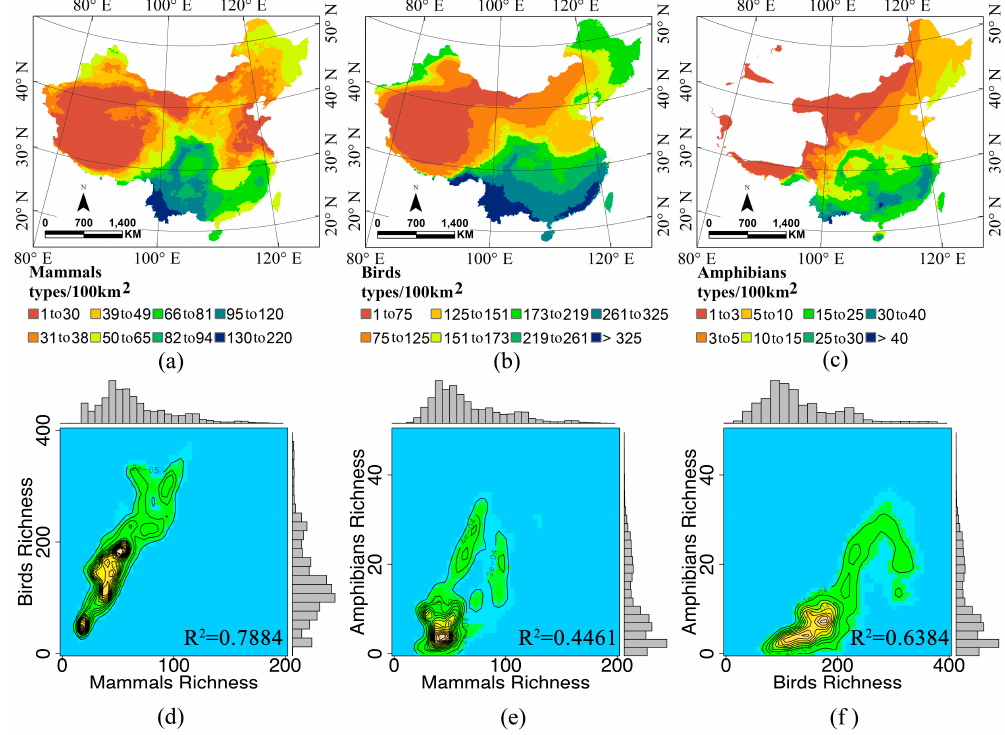
Figure 1. Geographical distribution of species richness based on field surveys (number of species/100 km 2 ) of ( a ) Mammals; ( b ) Birds; and ( c ) Amphibians [21–23]. Marine islands were not considered owing to a lack of species richness. The frequency distributions of the three groups are presented in an (x,y)-format of ( d ) (Mammals, Birds); ( e ) (Mammals, Amphibians); and ( f ) (Birds, Amphibians).